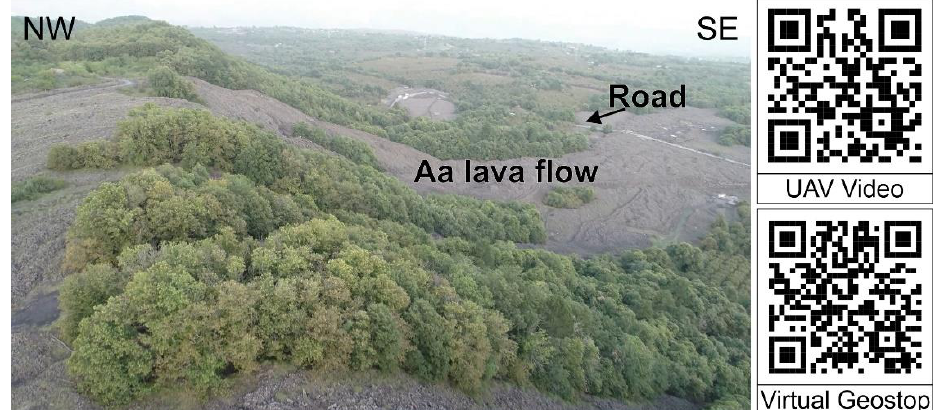
Figure 10. The image on the left shows geostop 8 through a NE-looking UAV-captured picture. The QR codes on the right enable opening the corresponding UAV-captured video and the related VG. By using a mobile phone or a tablet, open up the QR code reader. Hold your device over a QR code, so that it is clearly visible on your screen. Press the notification and wait a few seconds.